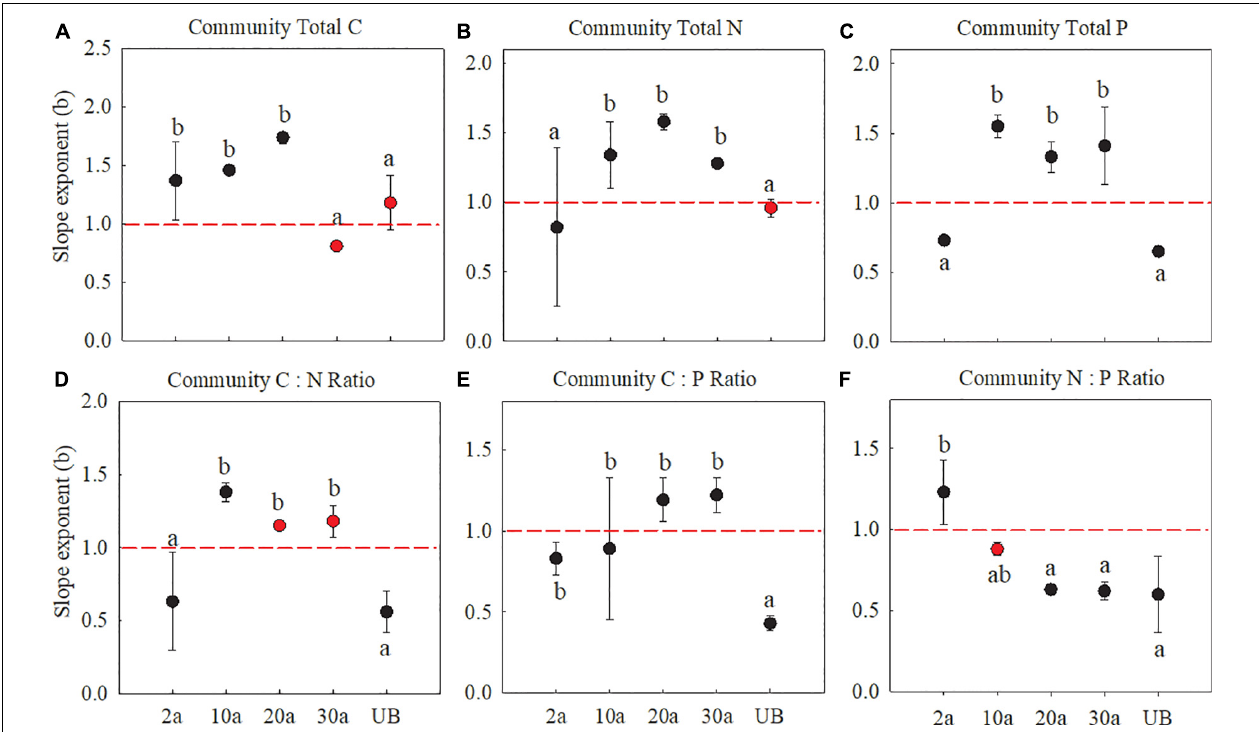
FIGURE 6 | Slope exponents (b) of C, N, and P with fine root (Y) vs. leaf (X) at the community level. 2a, 10a, 20a, and 30a are at year 2, year 10, year 20, and year 30 after recovery, respectively. UB, unburned. The sloping exponents of five recovery periods were shown with standard error. The slope exponents were estimated using RMA regressions. The summary of RMA, including intercept (a) and R 2 , is shown in Supplementary Table 3 . The number of the data involved in slope fitness in each recovery period was as follows: 2a: n = 9, 10a: n = 9, 20a: n = 9, 30a: n = 9, UB: n = 9. All regressions are significant at P < 0.05. Red dotted lines stand for the slopes are equal to 1. The red dots are that the exponents are not significantly different from 1 (isometric relationship) based on the likelihood tests. The different lowercase letters denote significant differences based on the likelihood tests. (A–C) The stoichiometry concentration. (D–F) The stoichiometry